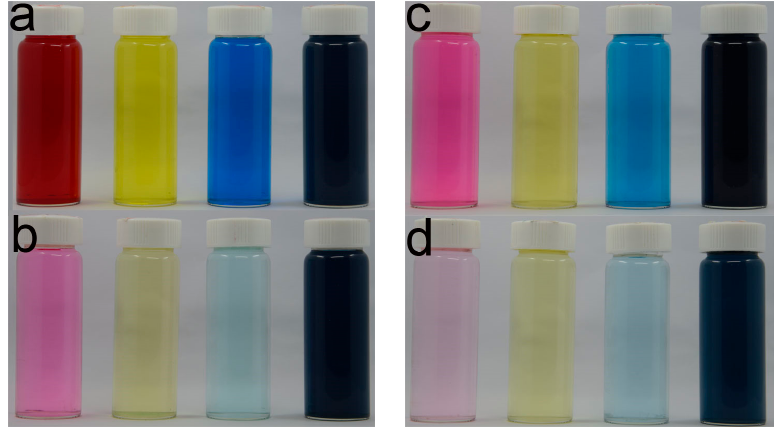
Figure 8. Washing wastewater of the ink-jet printed uncationized ( a ); and cationized cotton ( b ). Soaping residue of the ink-jet printed uncationized ( c ); and cationized cotton ( d ) (uncationizedand cationized cotton were washed and soaped under the same conditions. The volume of water was 200 mL for washing and 120 mL for soaping).